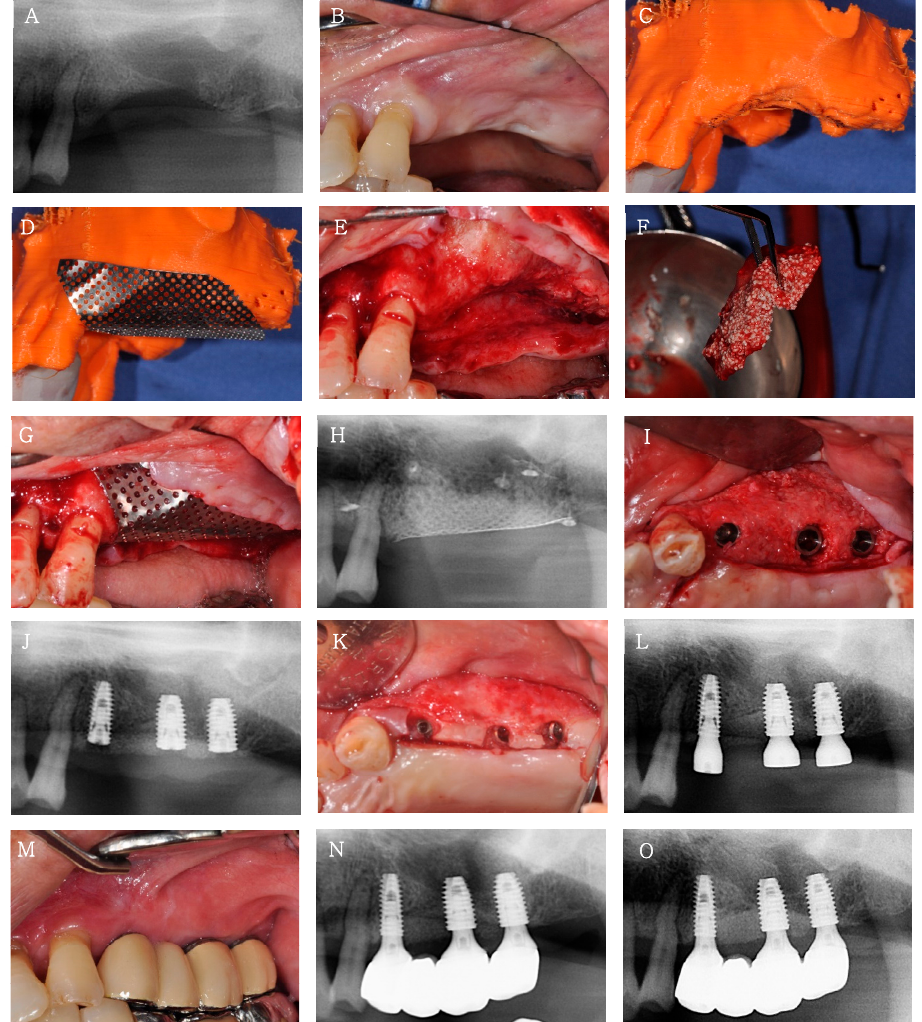
Figure 5. Clinical case 2. ( A , B ) Clinical and radiographic views before vertical ridge augmentation in the 24, 26, and 27 regions. ( C ) Three-dimensional printed model of the severely atrophic posterior maxilla. ( D ) A prefabricated titanium mesh on the 3D-printed model before clinical application. ( E ) Buccal view after flap elevation. ( F ) Bontree ® mixed with whole blood. A sticky bone graft with good manipulability is observed. ( G ) Buccal view of vertical ridge augmentation using Bontree ® and a titanium mesh. ( H ) Radiograph after vertical ridge augmentation. ( I ) Occlusal view of 24, 26, and 27 implants placed 6 months after vertical ridge augmentation. ( J ) Radiograph after the first-stage implant surgery. ( K ) Occlusal view of the second-stage implant surgery using apically positioned flap and punching technique 4 months after implantation. ( L ) Radiograph after the second-stage implant surgery. ( M , N ) Clinical and radiographic views of the final prosthesis 6 months after implantation. ( O ) Radiograph at 1 year after